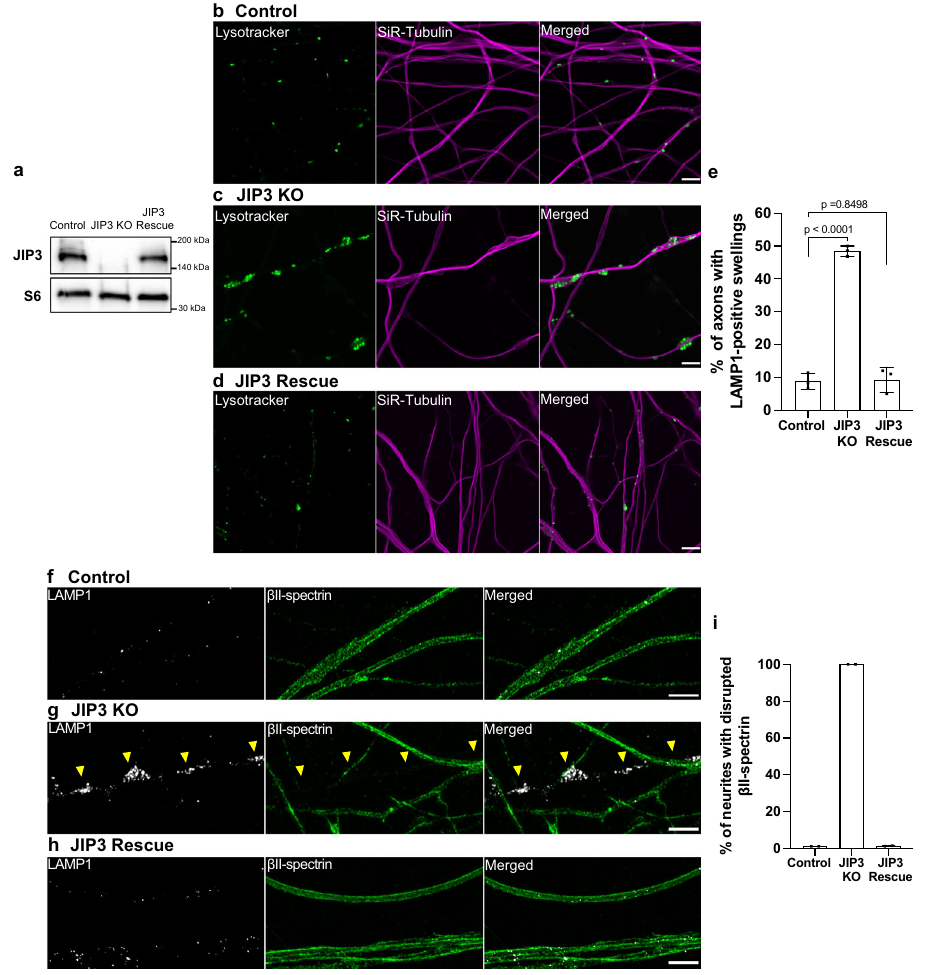
Fig. 5 Rescue of JIP3 KO phenotypes. a Immunoblots showing levels of JIP3 in control, JIP3 KO and JIP3 Rescue (gene-edited to WT) i 3 Neurons (day 17). Ribosomal protein S6 immunoblots served as loading controls. b – d Airyscan imaging of Lysotracker (green) and Sir-tubulin (magenta) in control ( b ), JIP3 KO ( c ) and JIP3 Rescue d ) i 3 Neurons (day 17), respectively (scale bars, 5 μ m). e Percentage of i 3 Neurons containing at least one lysosome-positive axonal swelling represented as mean ± SD, pooled from three independent experiments ( n ≥ 20 per experiment, 17 days of differentiation). f – h Airyscan microscopy images of lysosomes (white) and β II-spectrin (green) in control ( f ), JIP3 KO ( g ) and JIP3 Rescue ( h ) i 3 Neurons (Day 17), respectively. (yellow arrowheads highlight lysosome- fi lled swellings; scale bars, 5 μ m). Lysosomes and the periodic membrane skeleton were labeled with LAMP1 and β II- spectrin antibodies, respectively. i Percentage of swollen axons with disrupted periodic membrane skeleton represented as mean ± SD pooled from two independent experiments ( ≥ 8 analyzed per experiment). p -values were calculated using two-tailed Student ’ s t